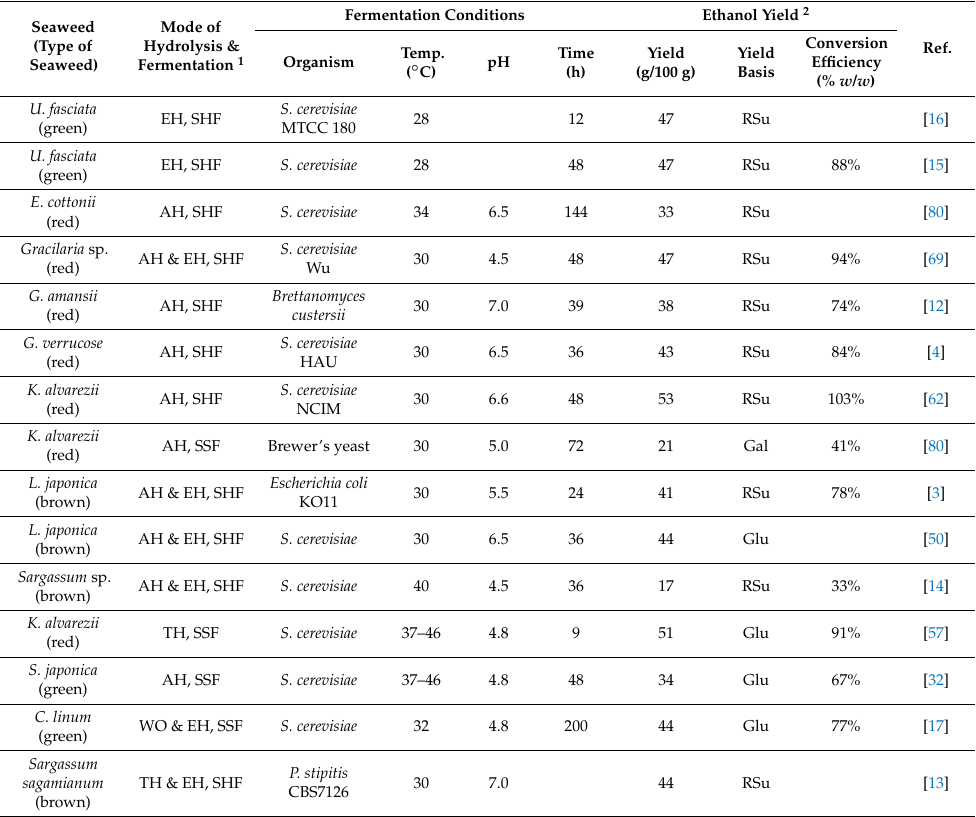
Table 5. Comparison of ethanol yield from various